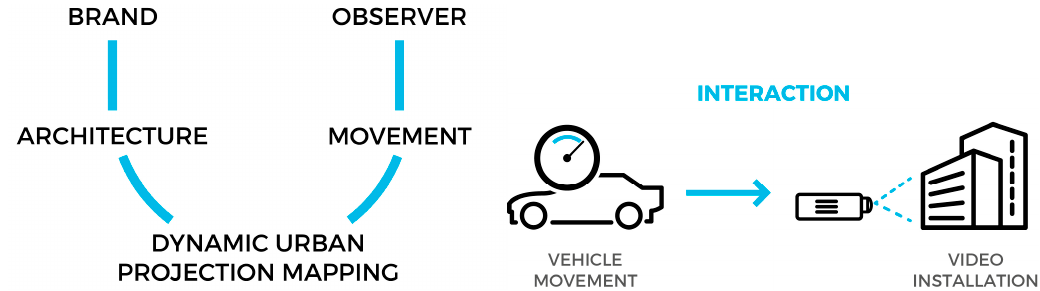
Figure 1. Dynamic urban projection mapping framework (image by Rosario Di